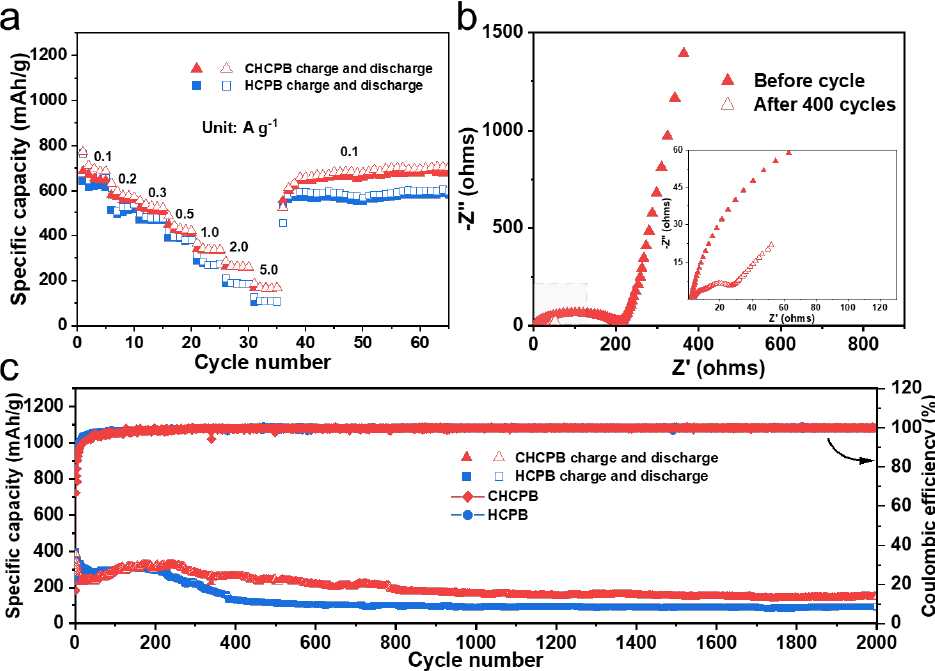
Figure 4. ( a ) Rate properties from 0.1 to 5 A g –1 and back to 0.1 A g –1 for HCPB and CHCPB; ( b ) EIS of CHCPB electrodes before and after the cycle; ( c ) long-term running properties of HCPB and CHCPB at 2 A g – 1 .